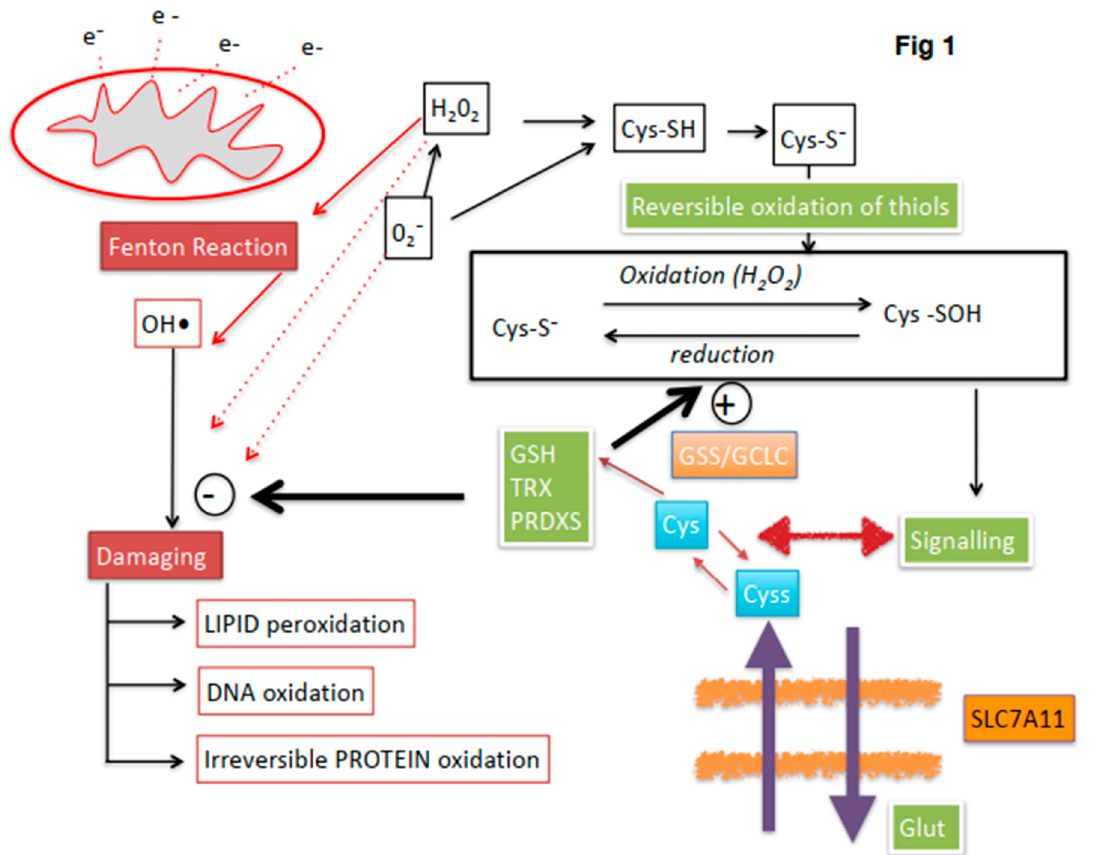
Figure 1. Overview of redox regulation in stallion spermatozoa. Electron (e − ) leakage at the mitochondria is one of the main sources of ROS. Mechanisms to maintain redox homeostasis include thioredoxin (TRX) and peroxiredoxin (PRDX) systems and gluthatione (GSH) (green boxes). The stallion spermatozoa can incorporate cystine (cyss) (blue boxes), through the SlC7A11 x-CT antiporter by exchange for intracellular glutamate (Glut). Cystine is reduced in the cytoplasm to Cysteine and contribute to the intracellular GSH pool by the action of the enzymes involved in the synthesis of GHS, Glutathion syntethase (GSS) and glutamate cysteine ligase (GCLC); this mechanism has been described only in horses. Controlled levels of ROS regulate sperm functionality through reversible oxidation of thiols in cysteine containing proteins (blank boxes). If redox regulation is lost, irreversible oxidation of thiols and oxidative attack to lipids DNA and proteins occurs leading to sperm malfunction and finally death (red boxes). The hydroxyl radical (OH • ) is the most damaging ROS, produced by the Habor–Weiss/Fenton reaction.